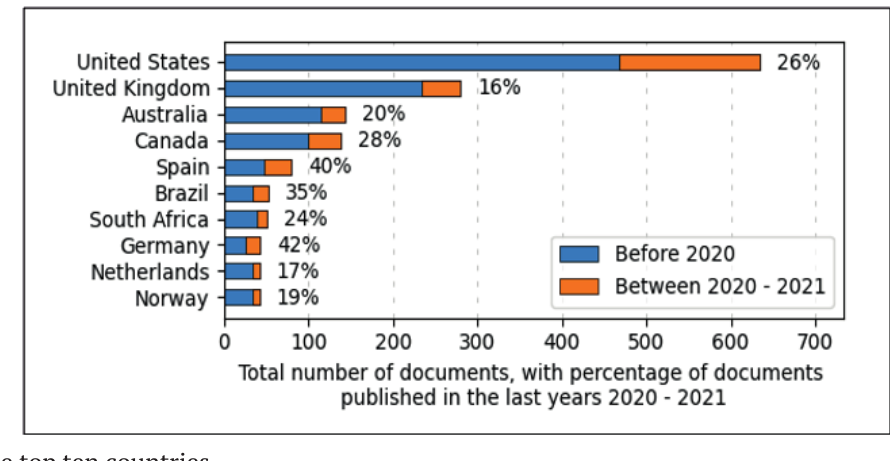
Figure 2. The top ten countries